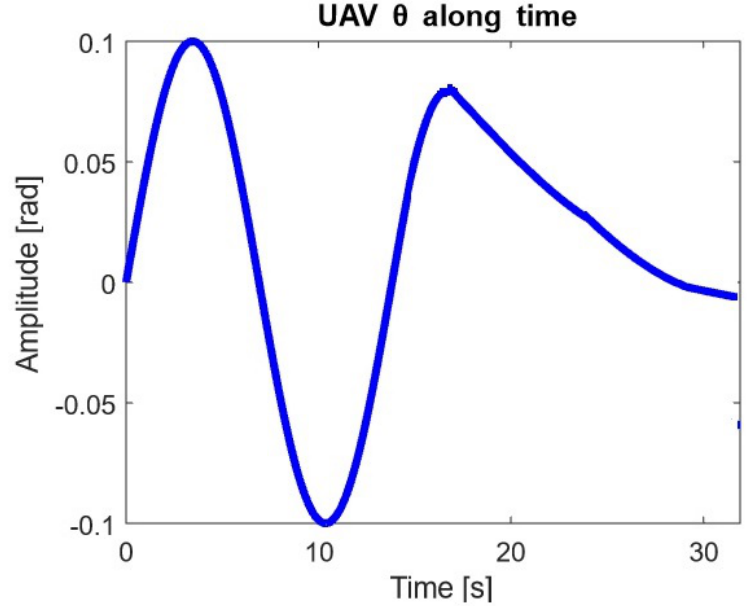
Figure 10. Quadrotor θ angle along time under MPC-PD